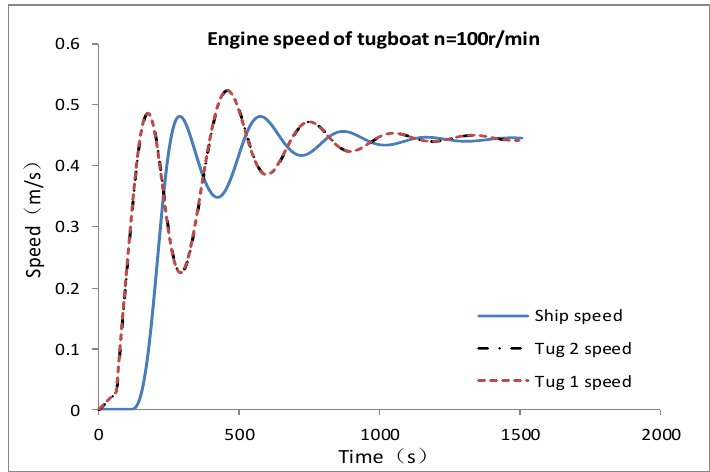
Figure 5. Speed analysis diagram of longitudinal tug ship.